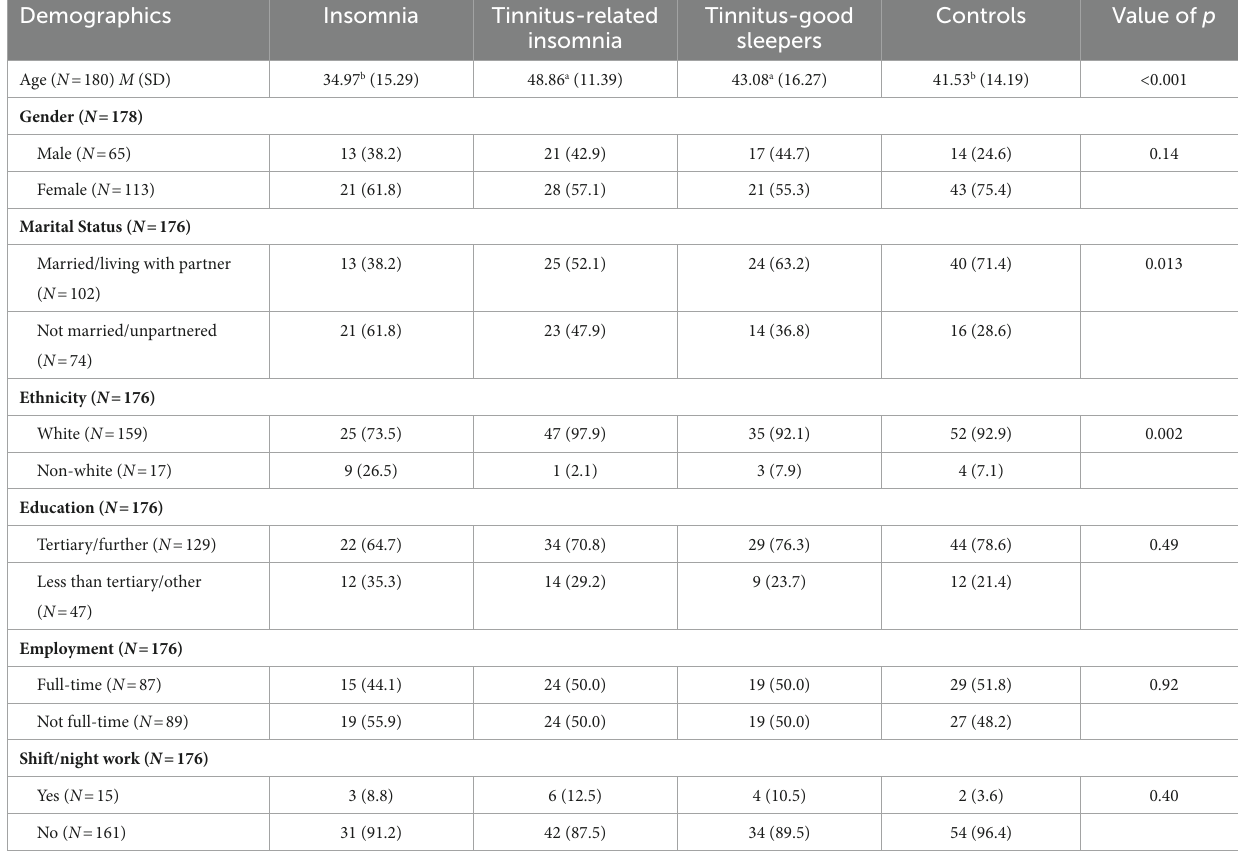
TABLE 1 Demographic characteristics of participants in the study exploring cognitive–behavioral factors in tinnitus-related